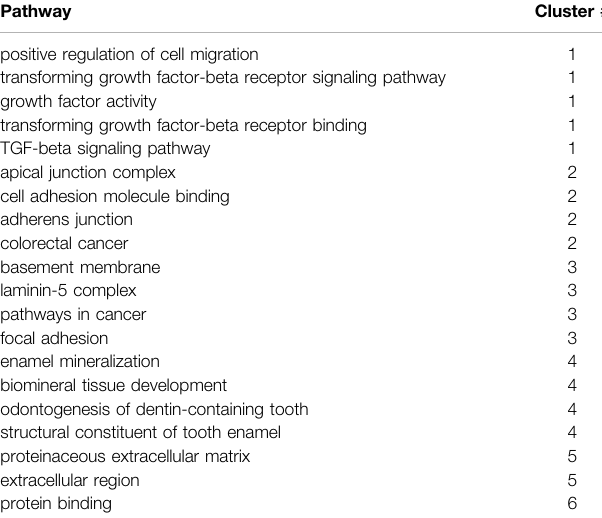
TABLE 5 | Top functional enrichment